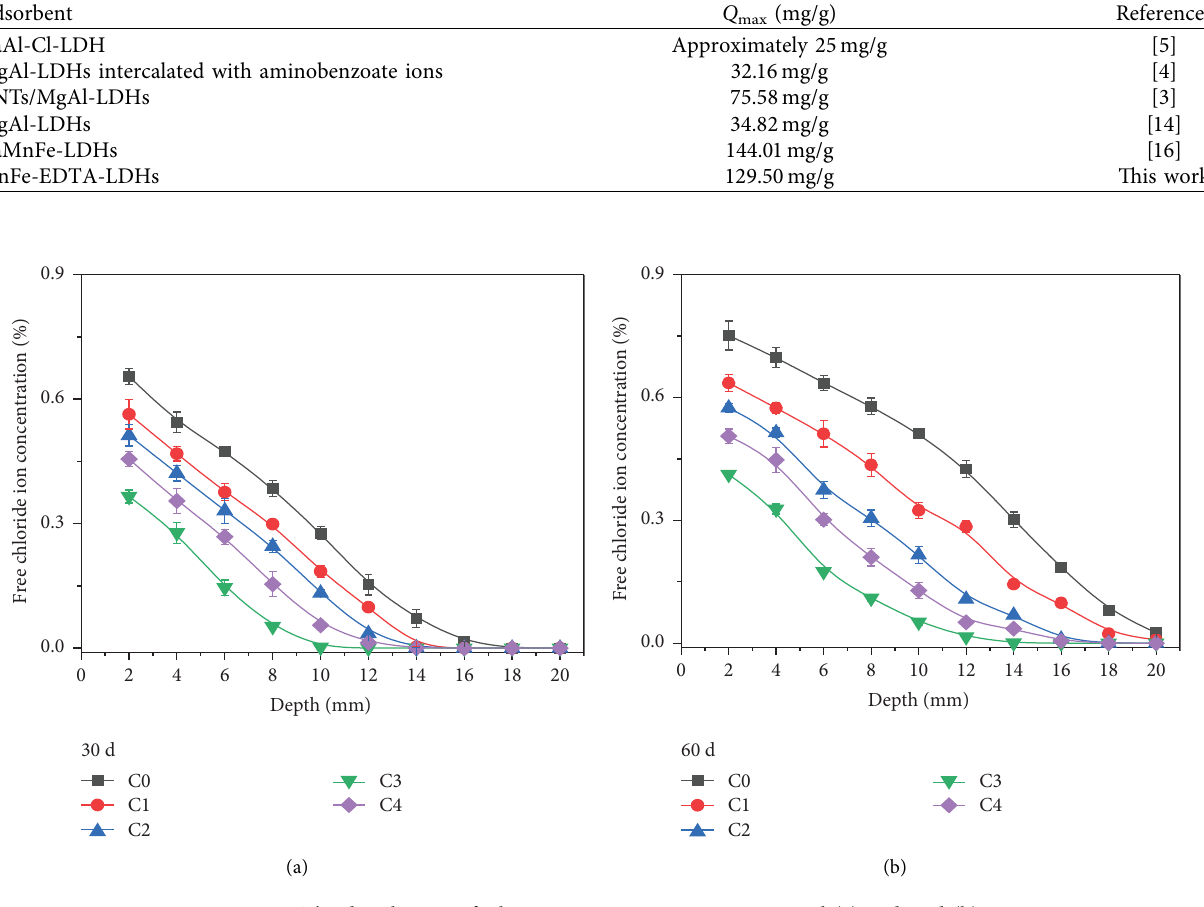
Figure 7: Te distribution of Cl − concentration in concrete at 30d (a) and 60d (b).